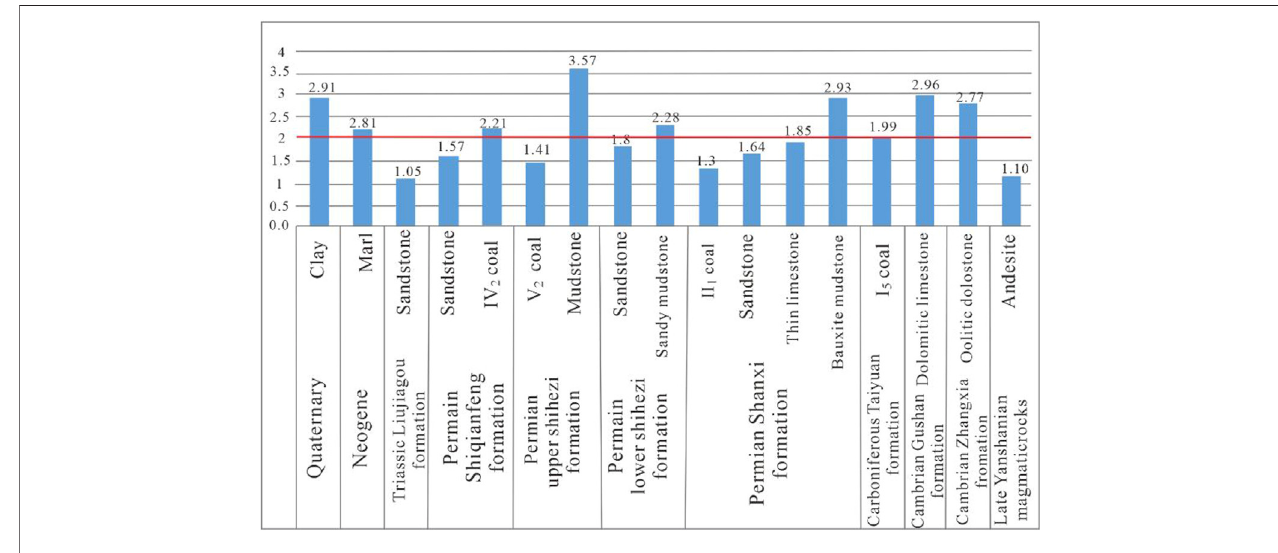
FIGURE 4 | Uranium content in the different strata (µg/g).